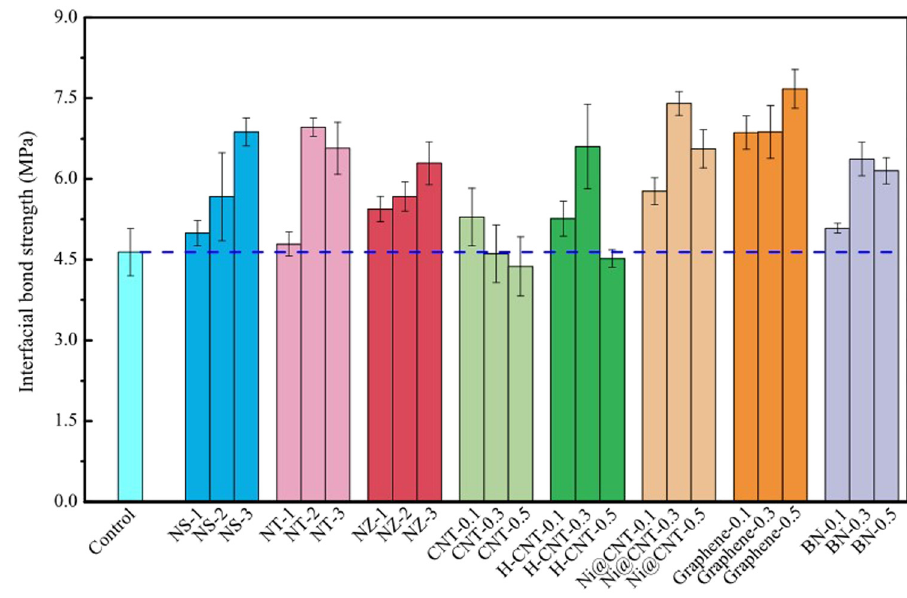
Figure 12: Bonding strength of concrete arti fi cial interface [ 102 ]